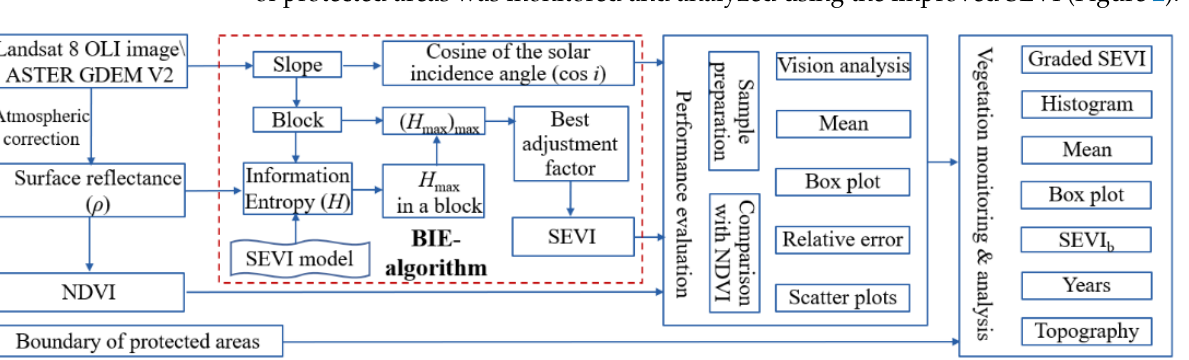
Figure 2. Flow chart of a new algorithm to calculate the improved SEVI using block information entropy (BIE-algorithm) and vegetation monitoring and analysis of protected areas.